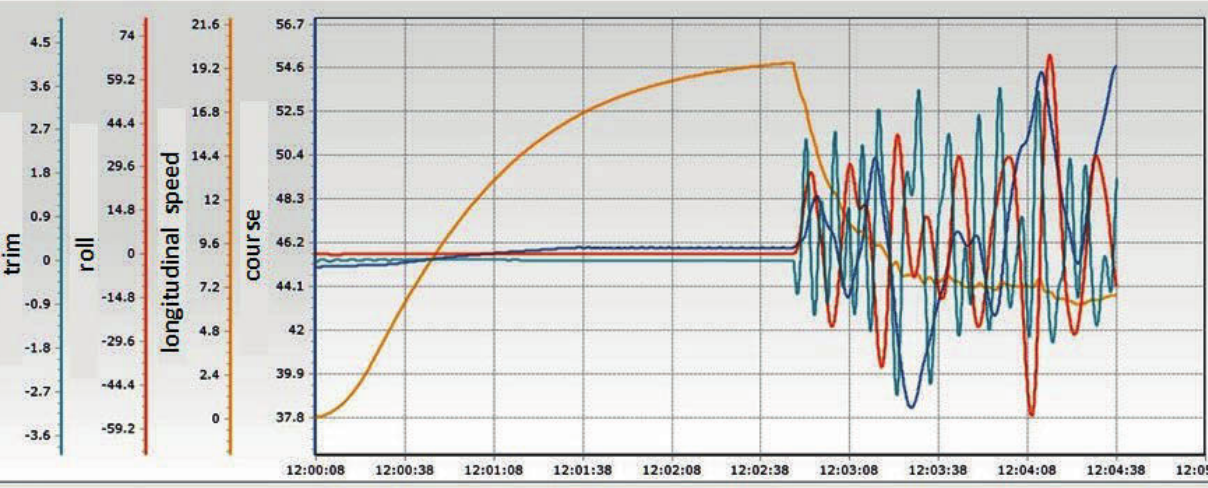
Fig. 5. Parameters of the Ro-Ro passenger ferry 13 movement for the initial course K = 45